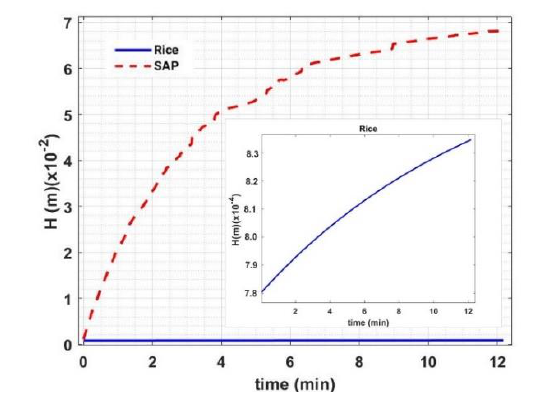
Fig. 7 Comparison of the expansion of the bed of particles with rice and SAP